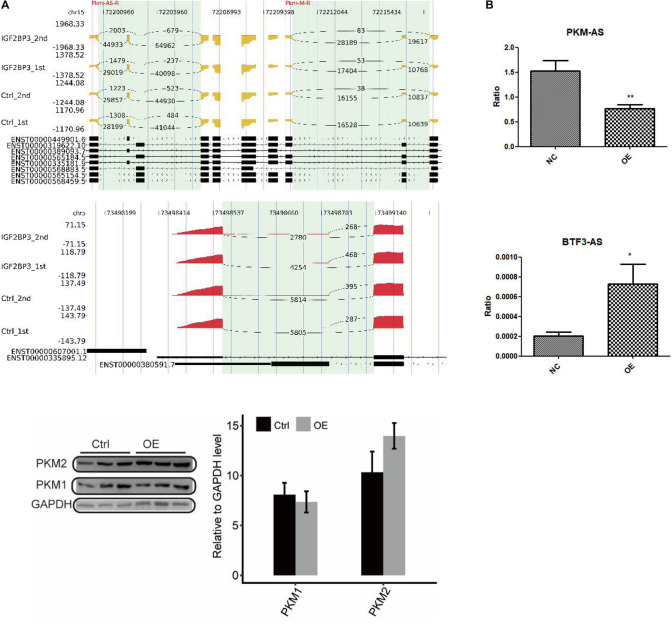
Validation of IGF2BP3-affected AS events. (A) The distribution of reads across the whole region of PKM and BTF3. (B) RT-qPCR validation of PKM and BTF3 ASEs regulated by IGF2BP3.